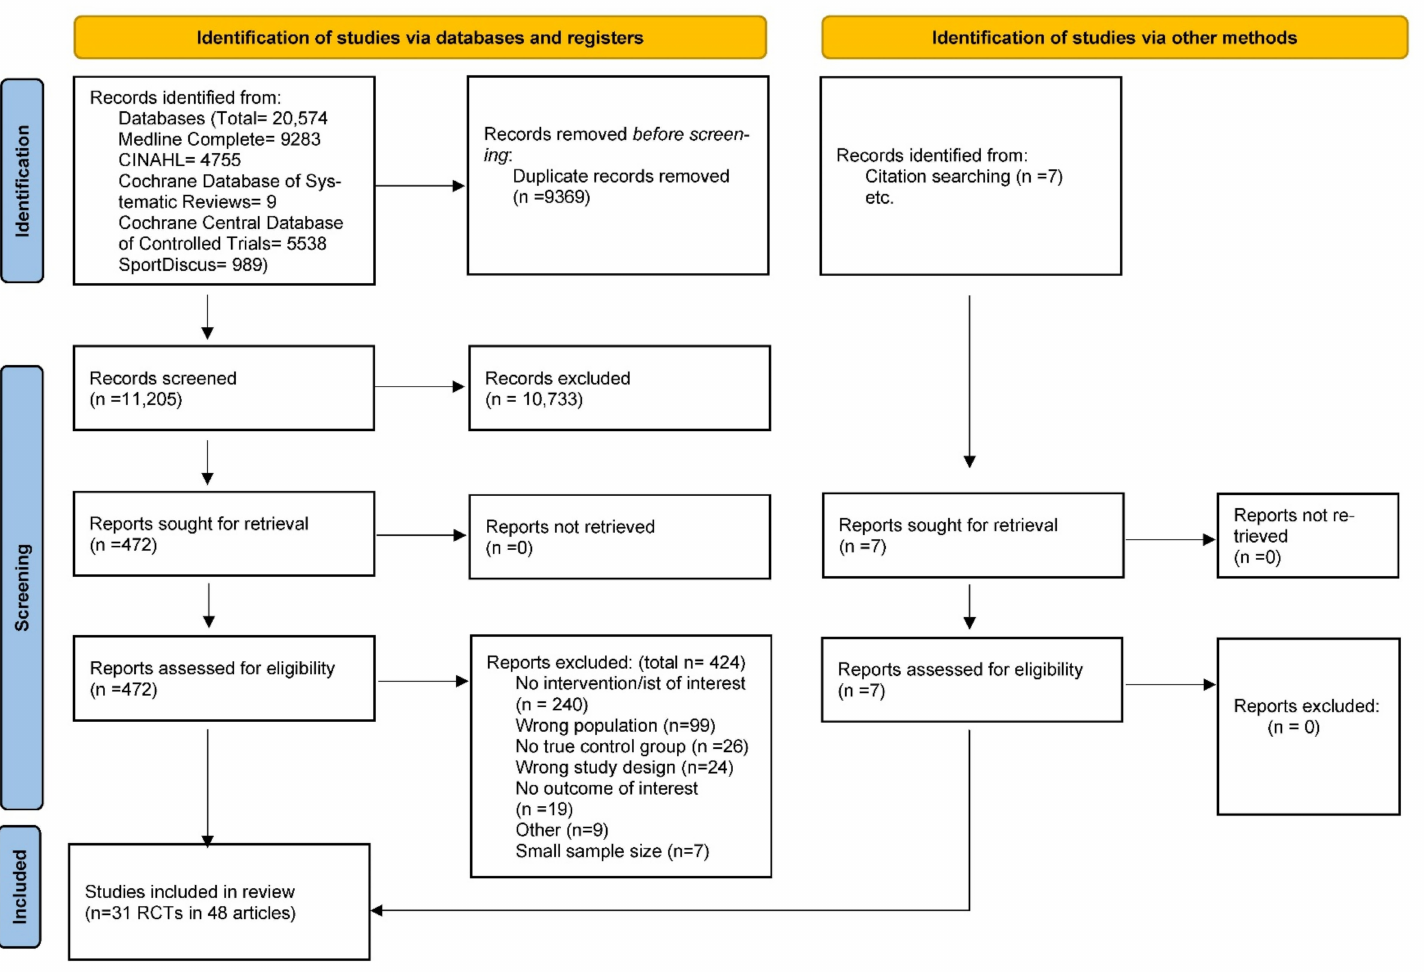
Figure 1. PRISMA 2020 flow diagram [19] for systematic review examining effect of nutrition and physical activity interventions provided by nutrition and exercise practitioners for the general population. From: Page, M.J.; McKenzie, J.E.; Bossuyt, P.M.; Boutron, I.; Hoffmann, T.C.; Mulrow, C.D.; et al. The PRISMA 2020 statement: an updated guideline for reporting systematic reviews. BMJ 2021;372:n71. doi: 10.1136/bmj.n71. For more information, visit: http://www.prisma-statement.org/ (accessed on 20 February 2022)